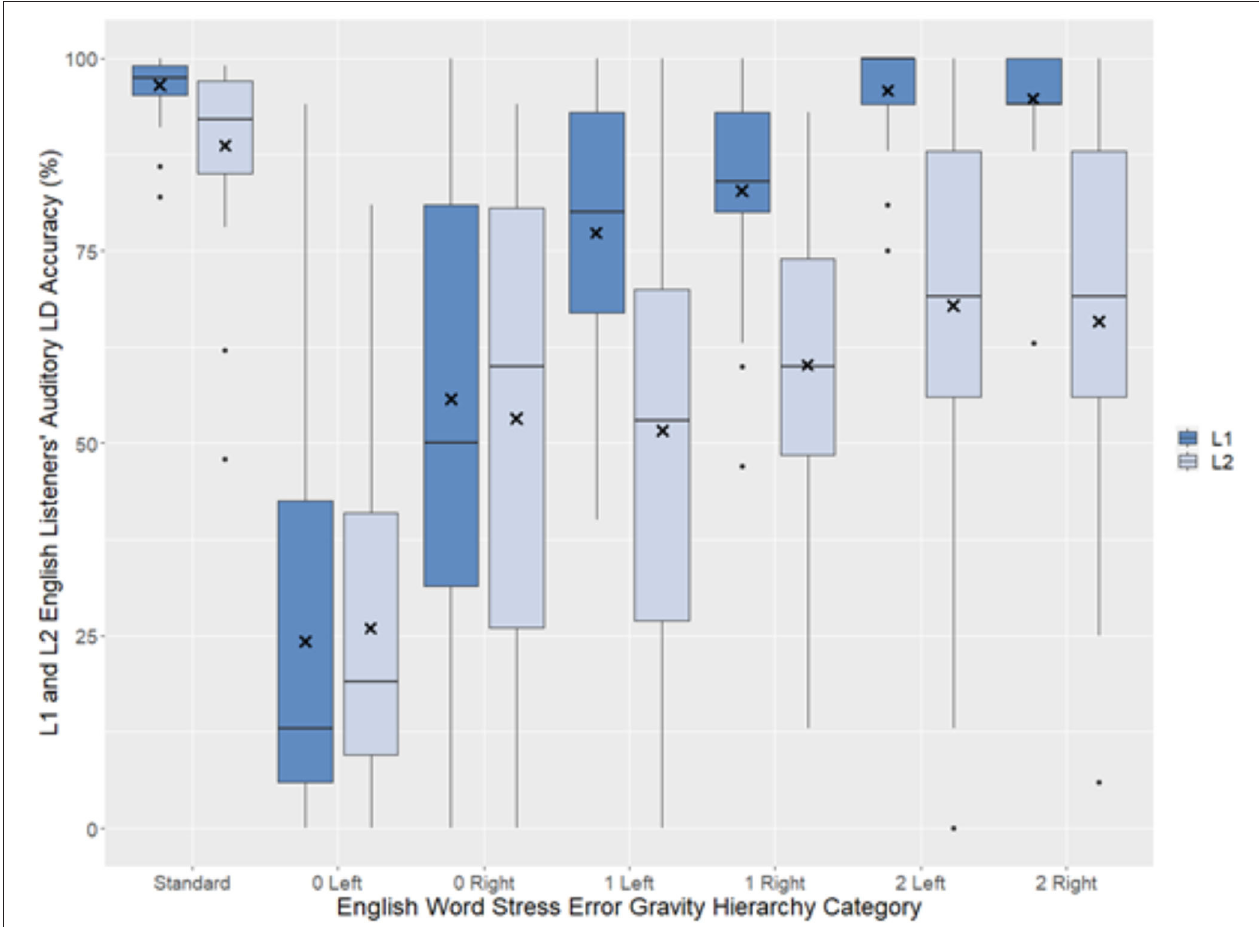
TABLE 3 | Percentage of mean difference between pairs of hierarchy categories in L2 listeners’ LD accuracy. Standard 0 Leftward 0 Rightward 1 Leftward 1 Rightward 2 Leftward 2 Rightward Standard 0 0.63* 0.36* 0.37* 0.25* 0.21* 0.23* 0 Leftward 0 0.27* 0.25 0.40 0 Rightward 0 0.17 1 Leftward 0 0.12 0.17* 0.15* 1 Rightward 0 0.05 0.03 2 Leftward 0 0.02 2 Rightward